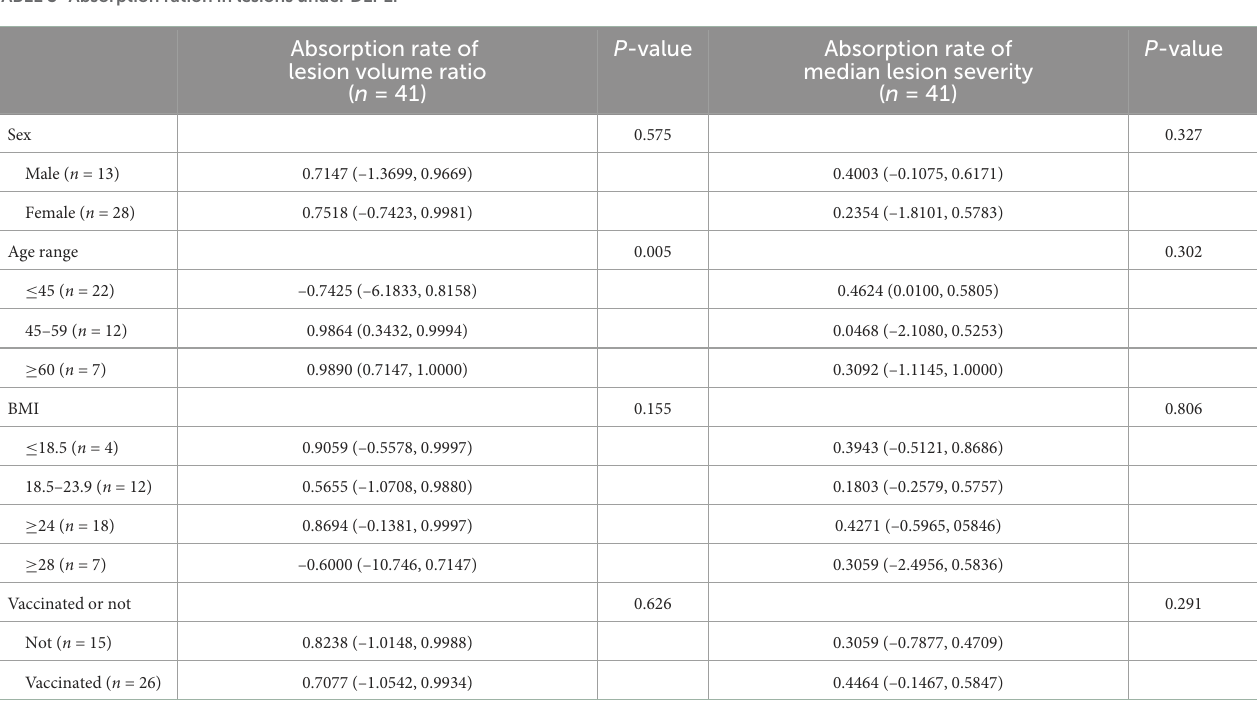
TABLE 3 Absorption ration in lesions under